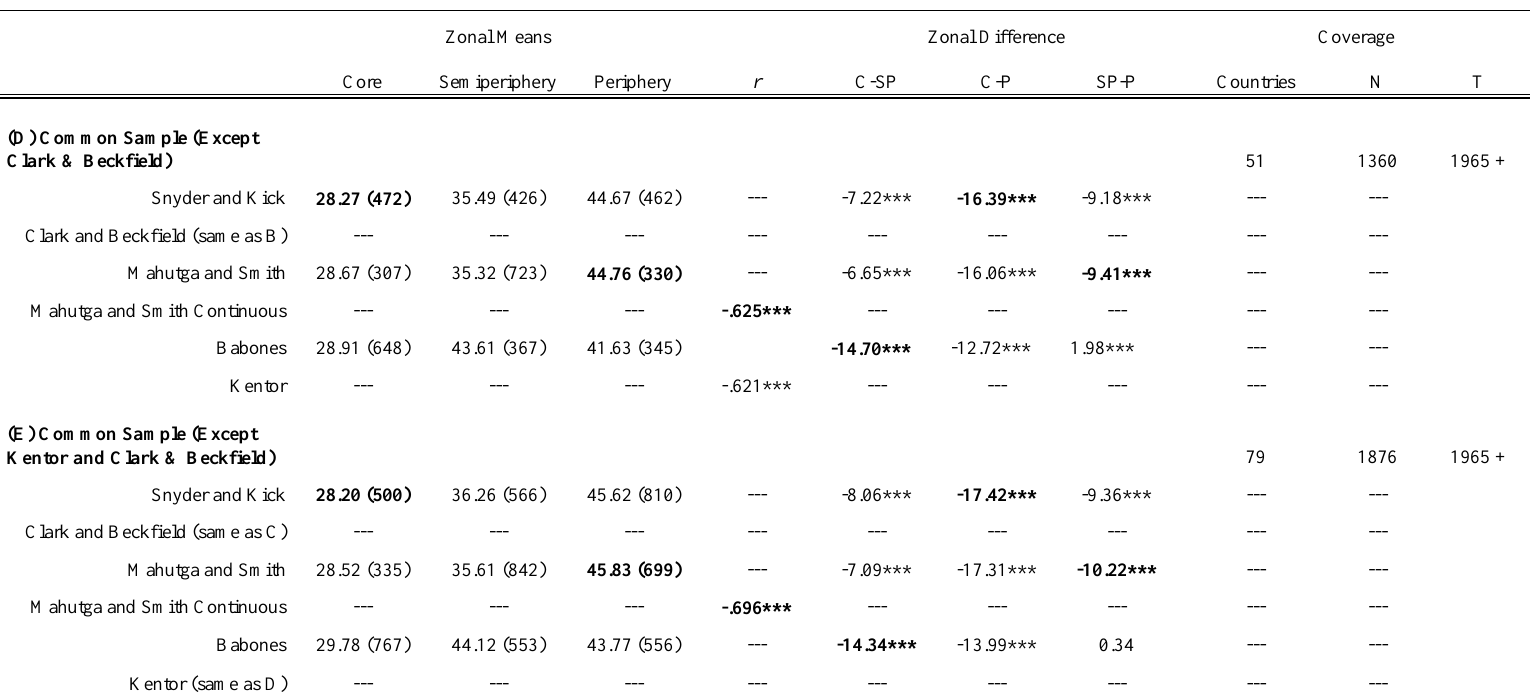
Table 3. Bivariate Descriptive Statistics for Association Between World-System Position and Gini by Sample Restriction and World-System Indicator